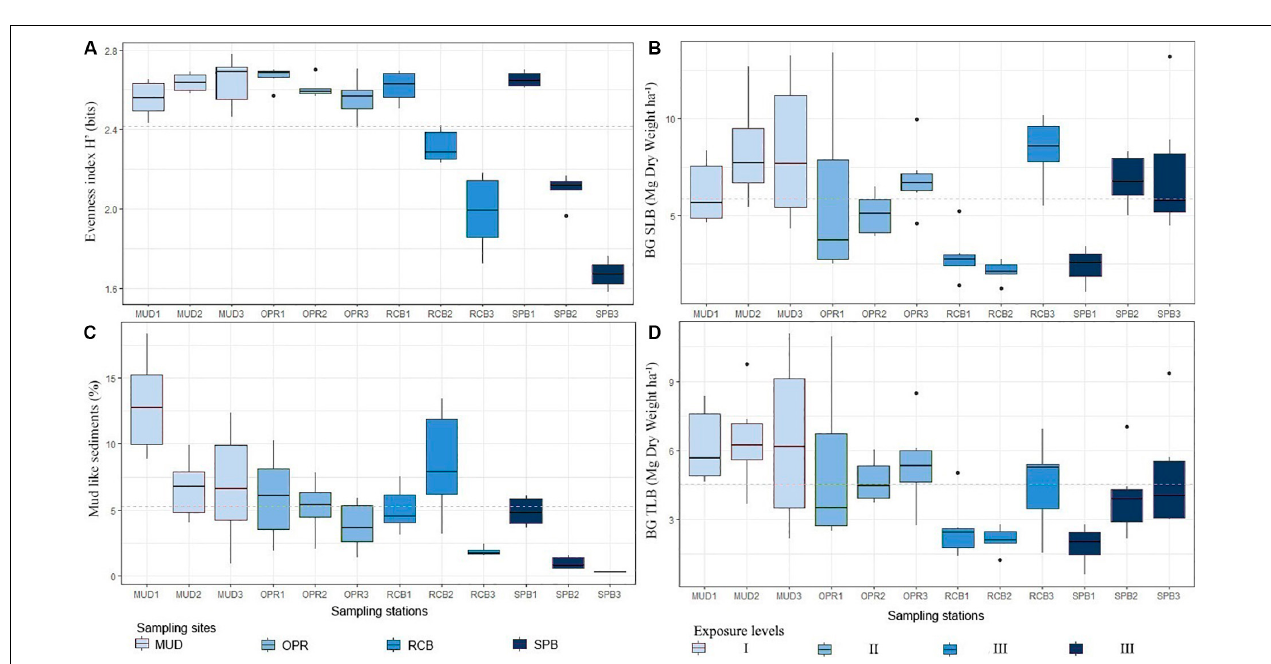
FIGURE 7 | Boxplots by sites (and exposure levels) MUD (I), OPR (II), RCB (III), and SPB (III) and by sampling stations (1 indicates deep water, 2 mid water and 3 shallow water meadows). (A) shows evenness index for granulometry profile H’ (bits), (B) shows belowground seagrass living biomass (Mg Dry Weight ha − 1 ), (C) is percentage of mud-like sediments per 100 g of dry weight (%) and (D) is belowground T. testudinum living biomass (Mg Dry Weight ha − 1 ). Each box is based on six replicates per sampling station. Study area means are represented by dashed lines. Exposure to waves levels is included (I, II, and